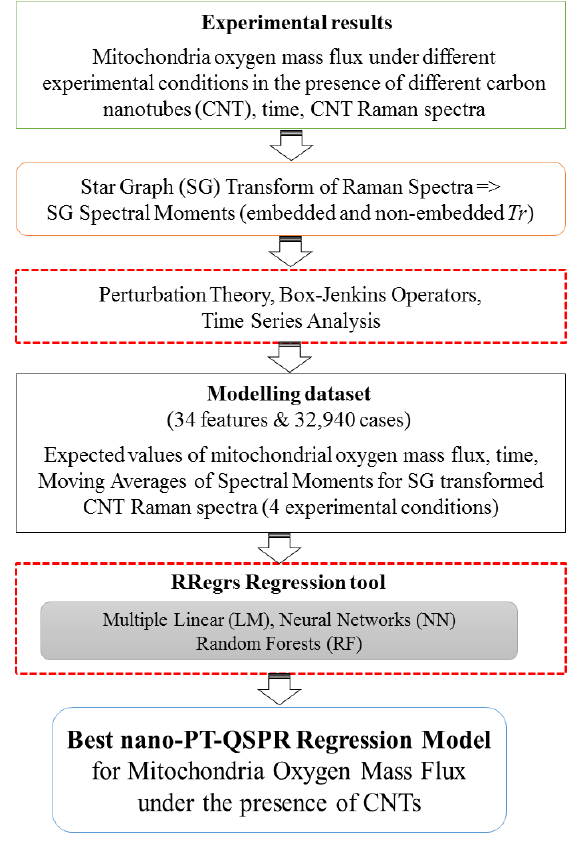
Figure 6. General workflow for the machine learning analysis.